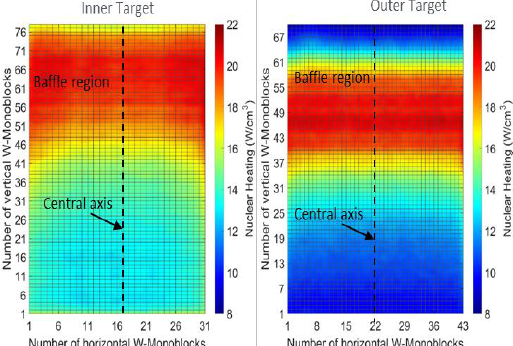
Figure 29. Poloidal profiles of the inner ( left ) and outer ( right ) target, highlighting the neutronics and thermal peak area.